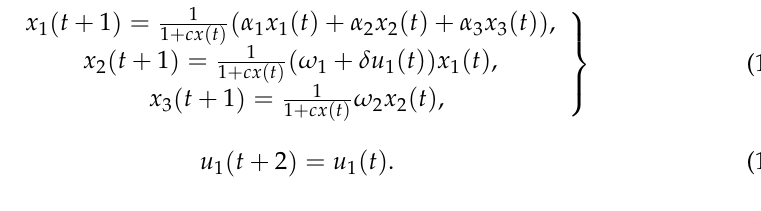
Figure 5. The solution of observer (14) with initial value z ( 0 ) = “unknown” state process with initial value [ ] T ux 1.5 51610 the “unknown” environmental change of the reproduction rate of the third age class.